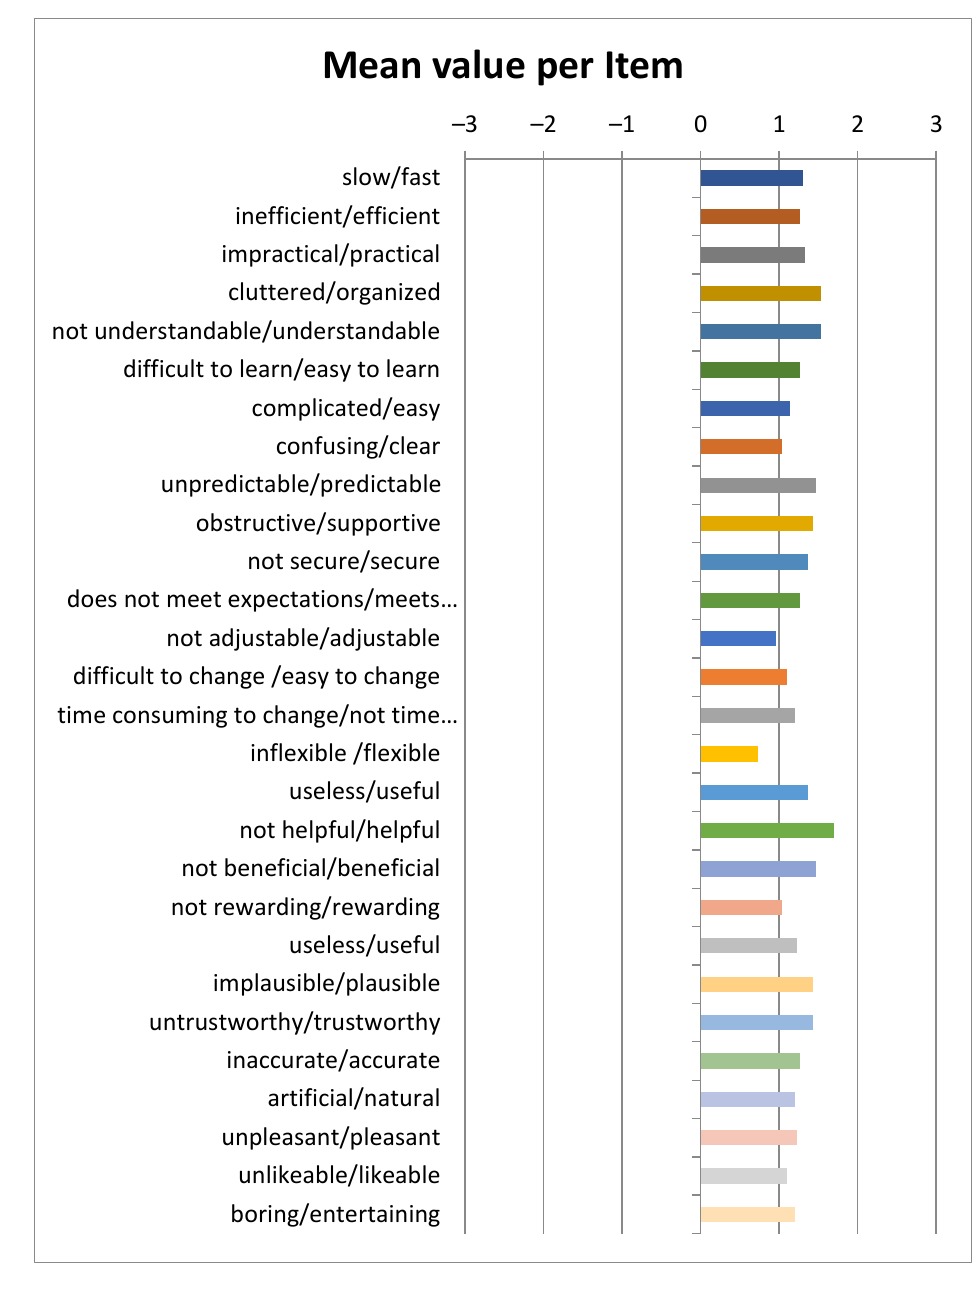
Figure 11. Mean value per Item.